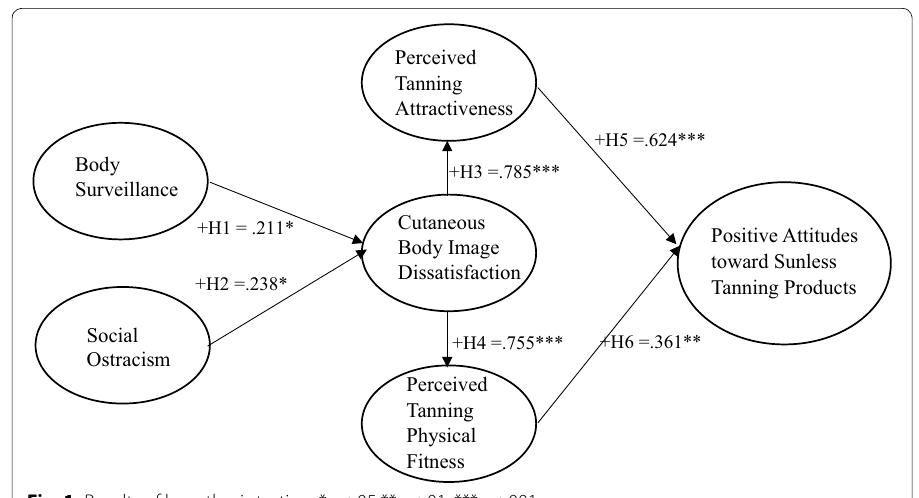
Fig. 1 Results of hypothesis testing. * p < .05 ** p < .01, *** p <